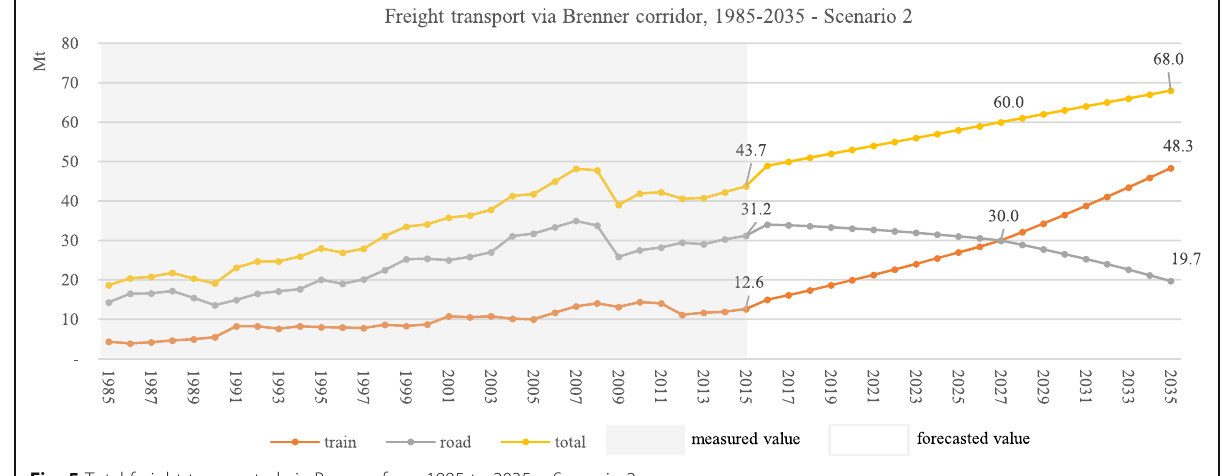
Fig. 5 Total freight transported via Brenner from 1985 to 2035 – Scenario 2